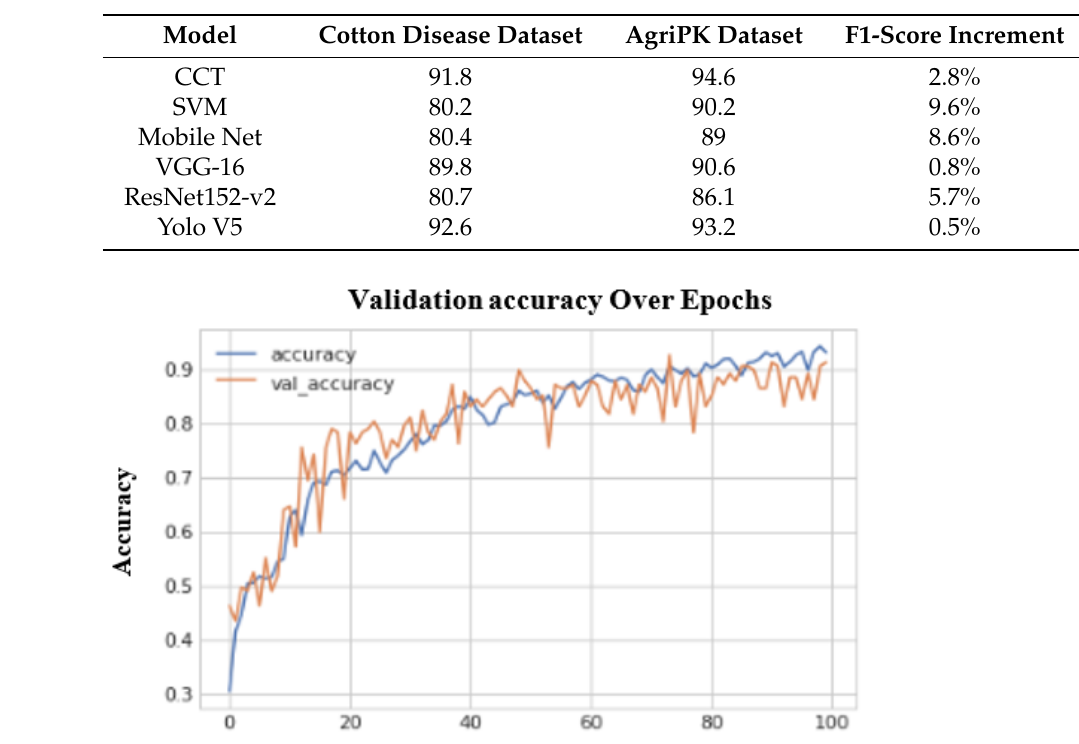
Table 5. Performance evaluation of AgriPK and Cotton Disease Dataset.